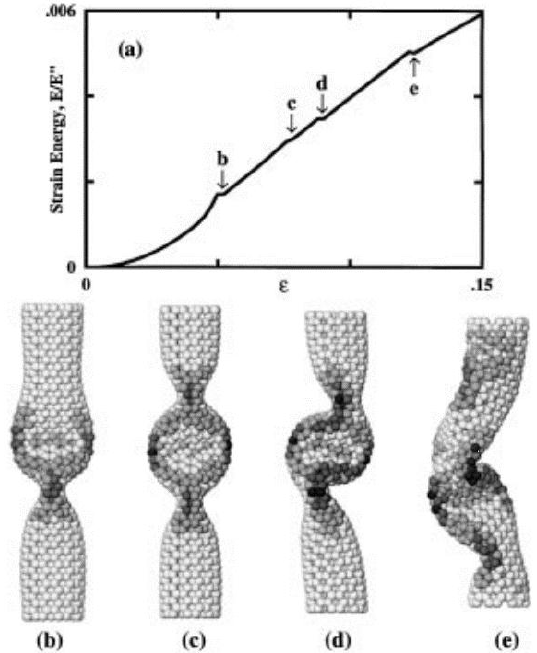
Figure 15. Series of TEM images of deformation processes for MWNTs initiated by applying compressive force in the sample direction. Adapted with permission from [69], Copyright American Physical Society, 1996.